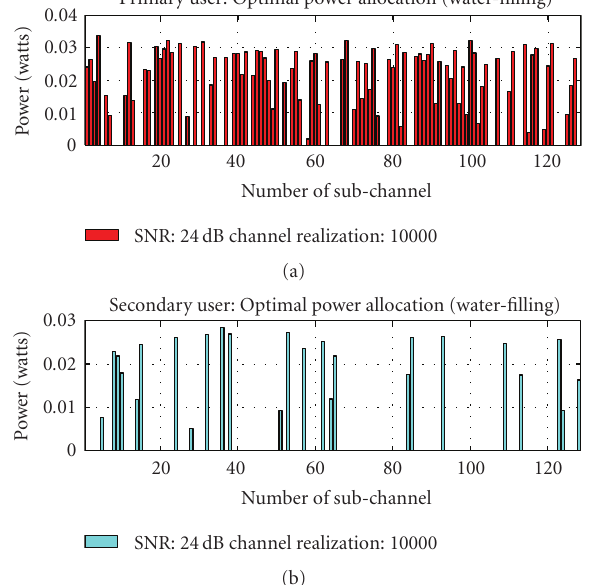
Figure 2: Optimal distribution and subdistribution of power (primary/secondary user), for channel realization number 10,000 with an SNR = 24